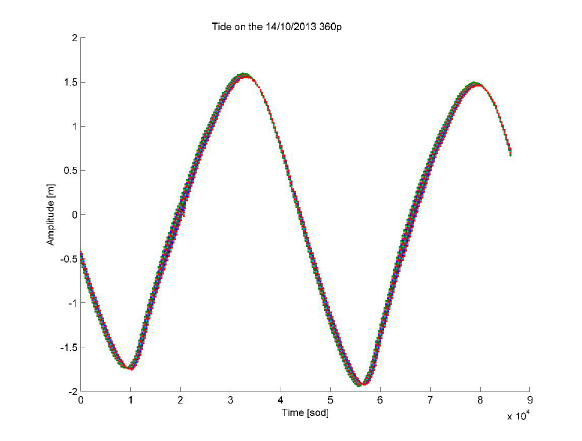
Figure 5: Calculated tide values in the grid points along the river segment using TCARI. Each color represents different grid point.